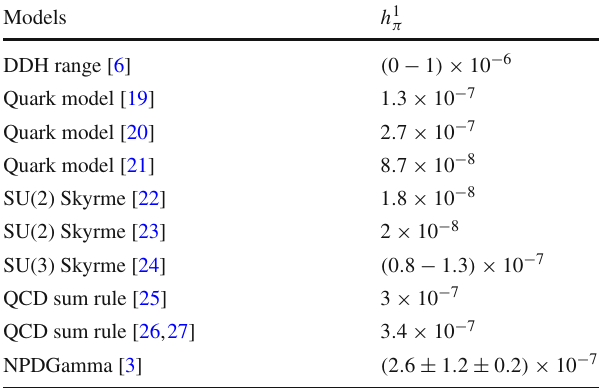
Table1 Existingmodelcalculationsof h 1 π incomparisontotheimplied value from the NPDGamma experiment quoted in Ref. [3]